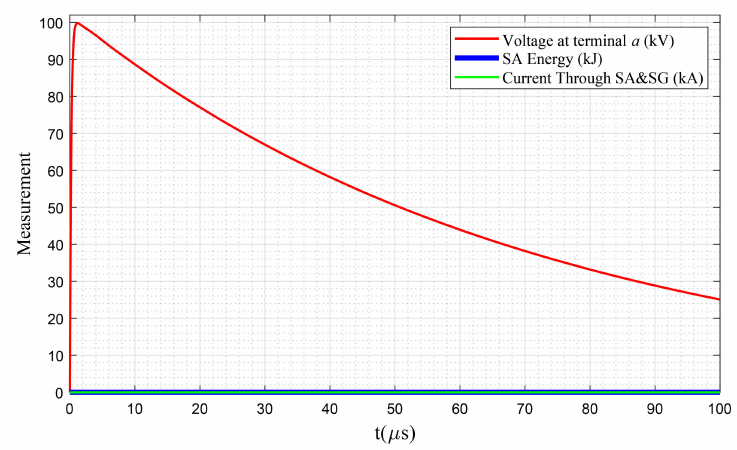
Figure 18. Performance of surge arrester and spark gap connected in series; scenario 1, SA-12a under 100 kV lightning impulse.